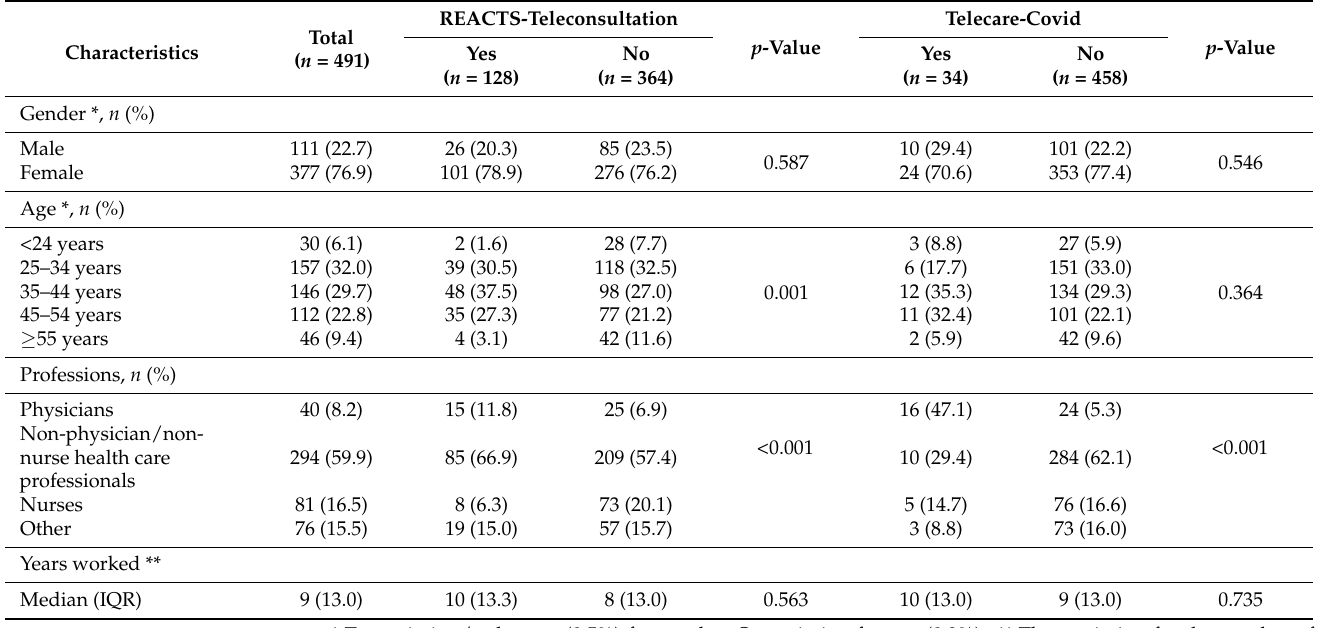
Table 2. Characteristics of participants who evaluated REACTS-Teleconsultation and Telecare